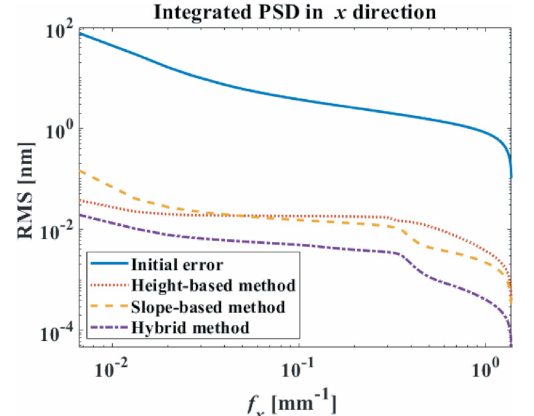
Figure 8 Integrated PSD distributions in the x -direction calculated from the residual height errors estimated with the height-based, slope-based and hybrid methods.